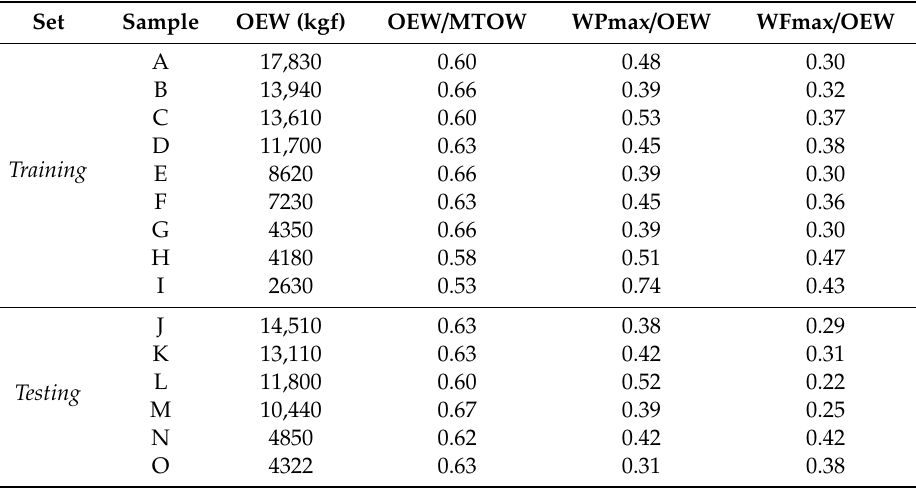
Figure 1. Specific range data with altitude variation for the aircraft from the training set of Table 1. Table 1. Sets, samples, and aircraft weights.